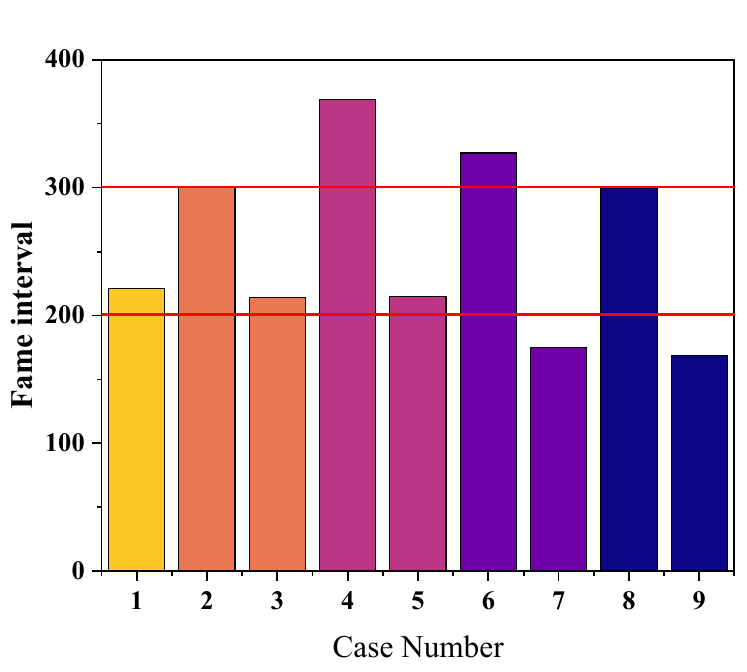
Figure 4. The fame interval of different cases.